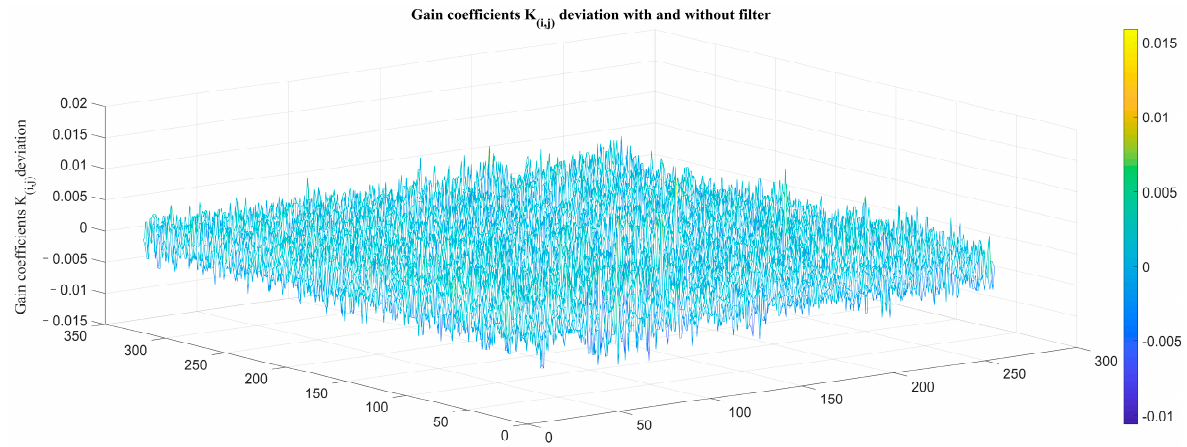
Figure 16. Deviation of TPC gain coefficients K i,j with and without atmospheric transmittance equiv- alent analog filter.